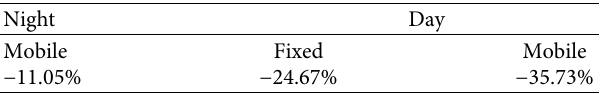
Table 4: Comparison of the accident likelihood at night and in the daytime and fixed or mobile hazard condition.